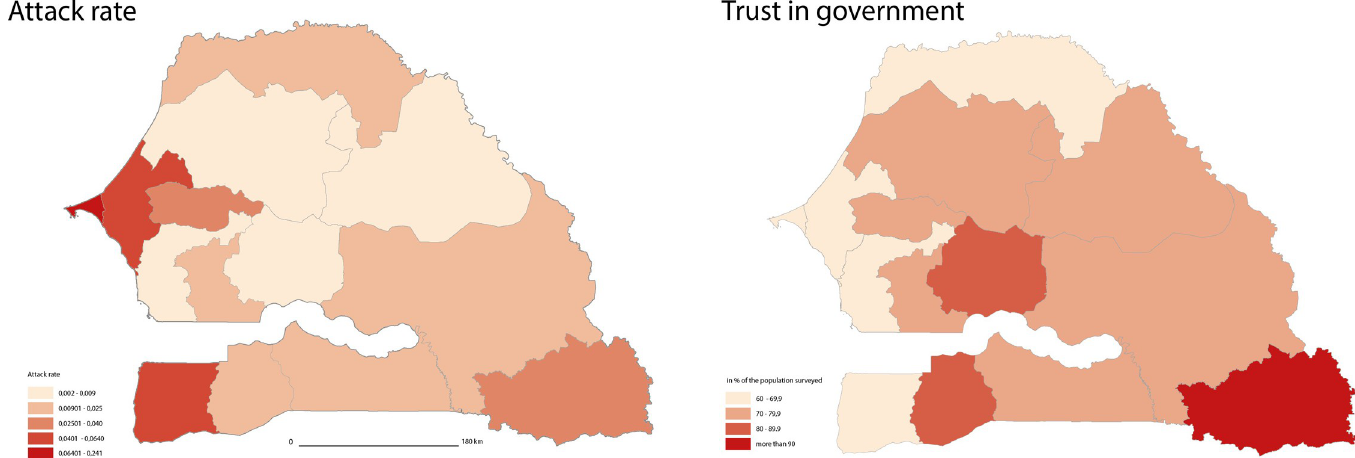
Fig 4. Regional distribution of attack rate and trust in